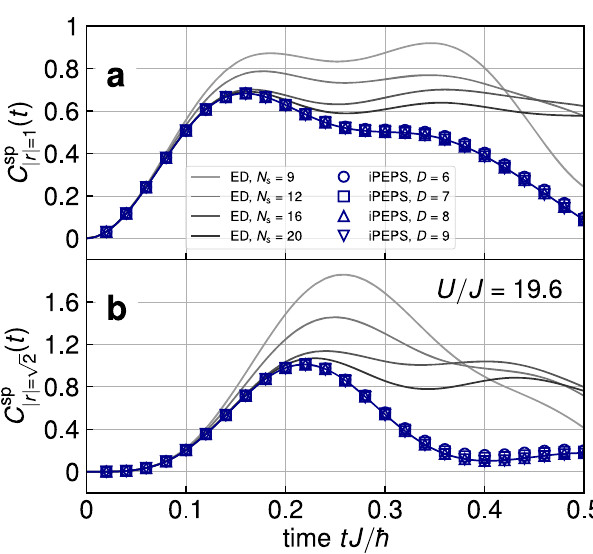
Fig. 2 Single-particle correlation functions C sp r ð t Þ in the case of a sudden quench. Comparison is made between the in fi nite projected entangled pair state algorithm (iPEPS, blue lines with symbols) and the exact diagonalization method (ED, gray lines). The unit of time is taken as the inverse of the strength of the hopping J . U is the strength of the interaction. D is the bond dimension. N ffiffiffi p s is the system size. The correlations at distances ( a ) ∣ r ∣ = 1 and ( b ) j r j ¼ 2 are shown. Both results overlap in a short time.